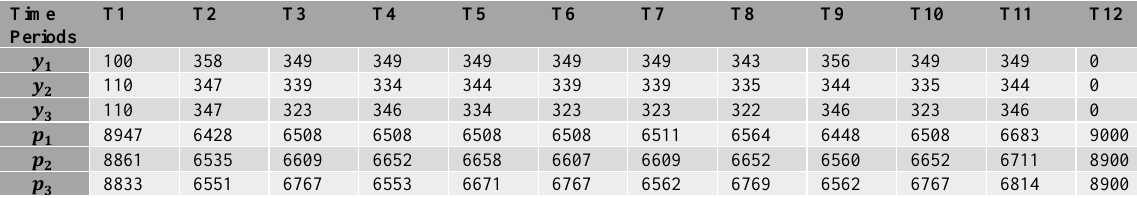
Table 5. Optimal value of sales and price (In